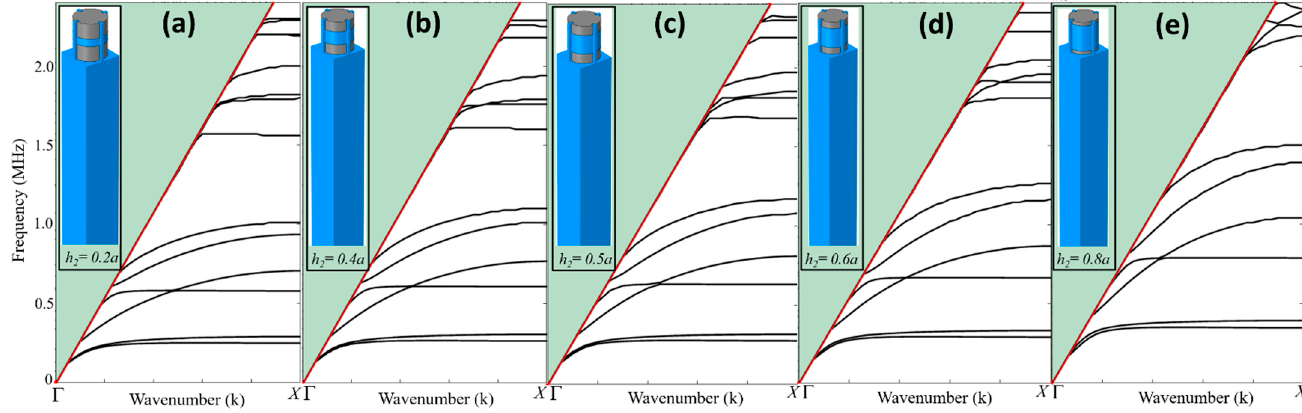
Figure 5. ( a ) SAW band structure; ( b ) transmission curve; and ( c ) SAW PnC vibration modes. Next, the height of Si, i.e.,